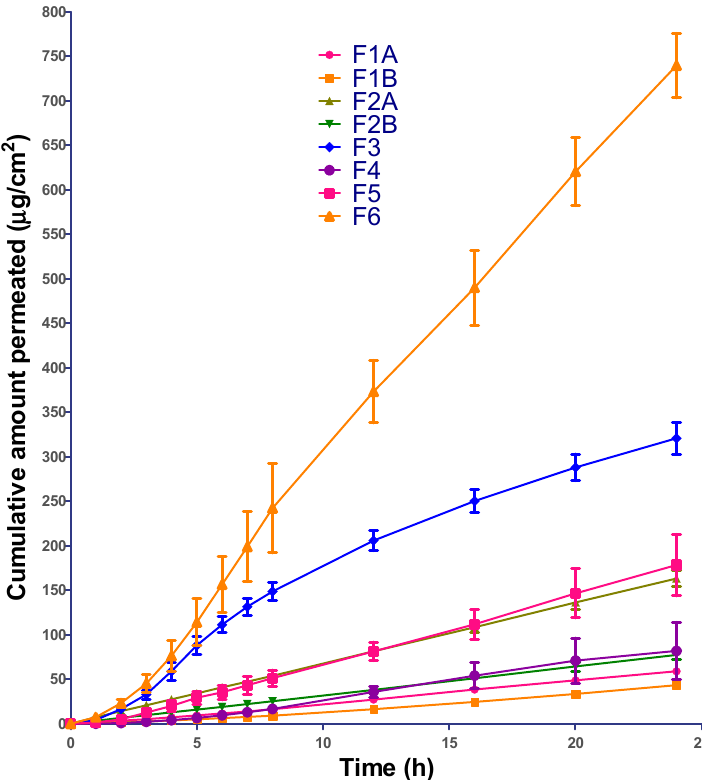
Pharmaceutics 2020 , 12 , x Figure 4. In-vitro permeation profile of all the formulations. Figure 4. In-vitro permeation profile of all the formulations.